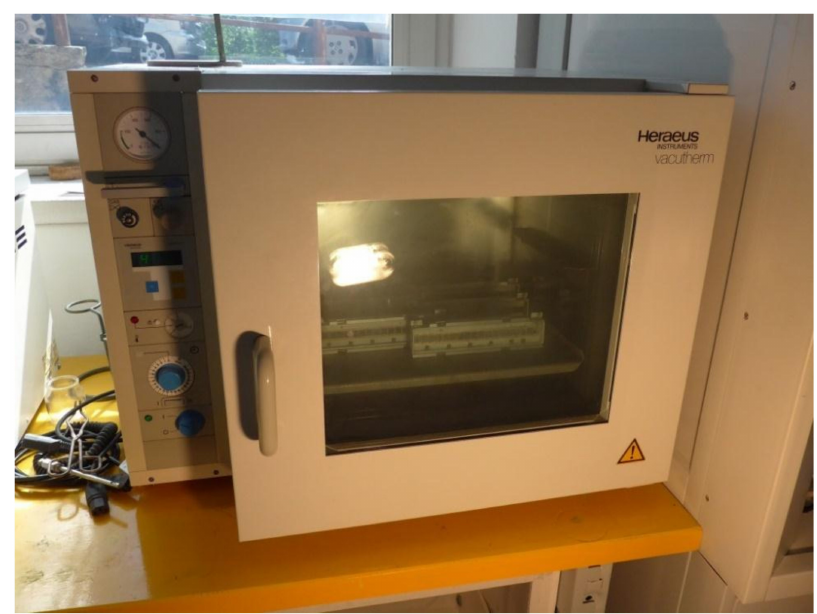
Figure 6. External view of the climatic chamber.